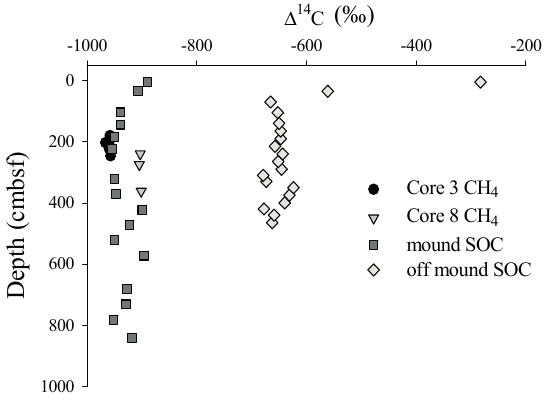
Figure 2. Δ 14 C CH4 of free gas and SOC at on-mound and off-mound sites.